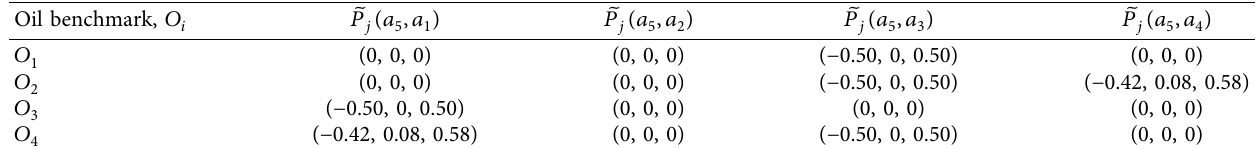
Table 13: Fuzzy preference function, 􏽥 P